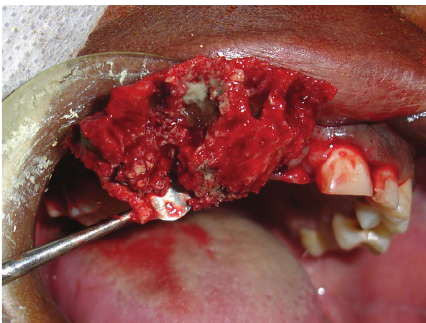
Figure 4: Clinical image at 6-month follow-up. Note complete healing of treated